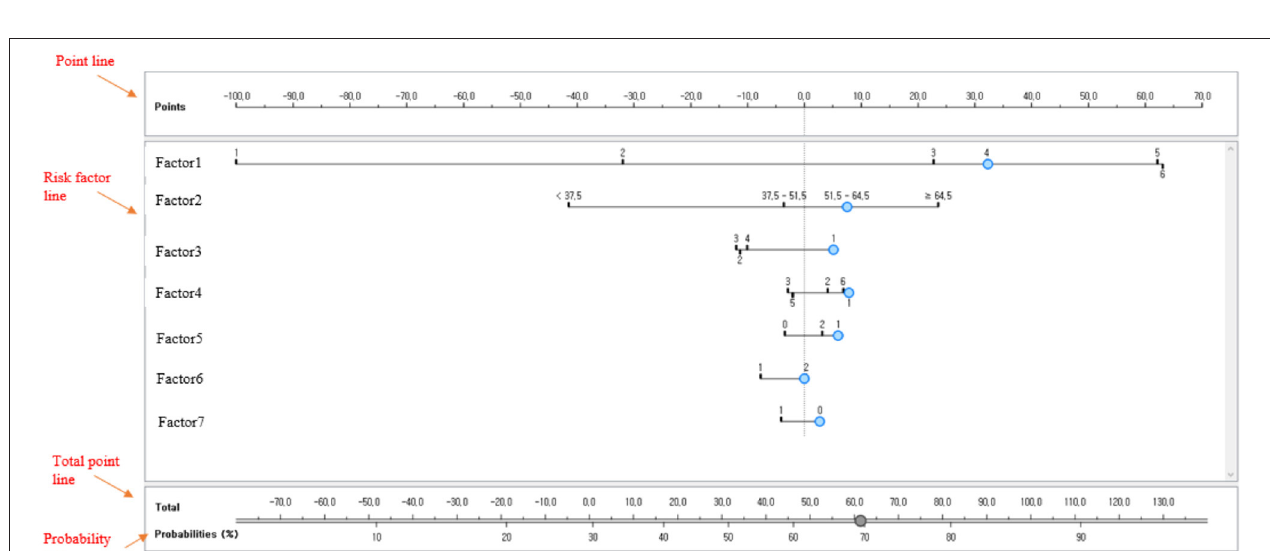
FIGURE 4 | Example of a naive Bayesian